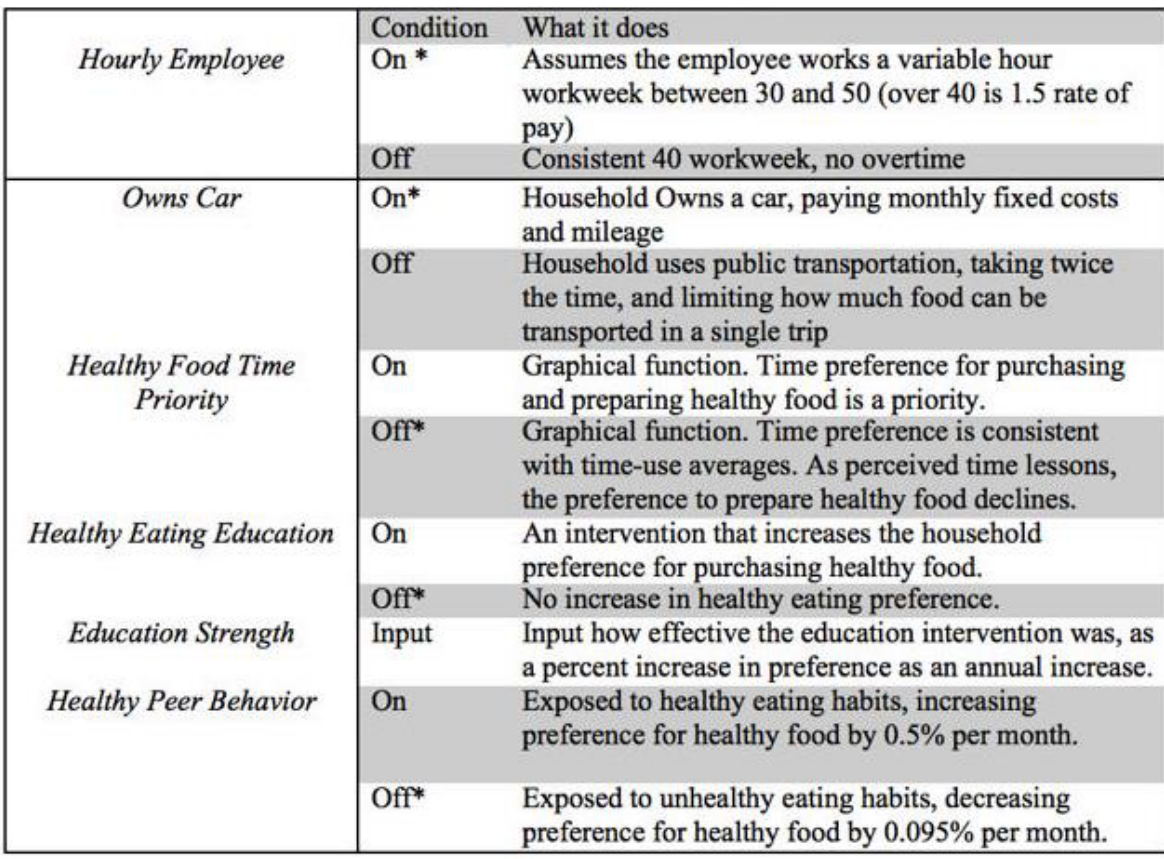
Table 1. Interface Intervention